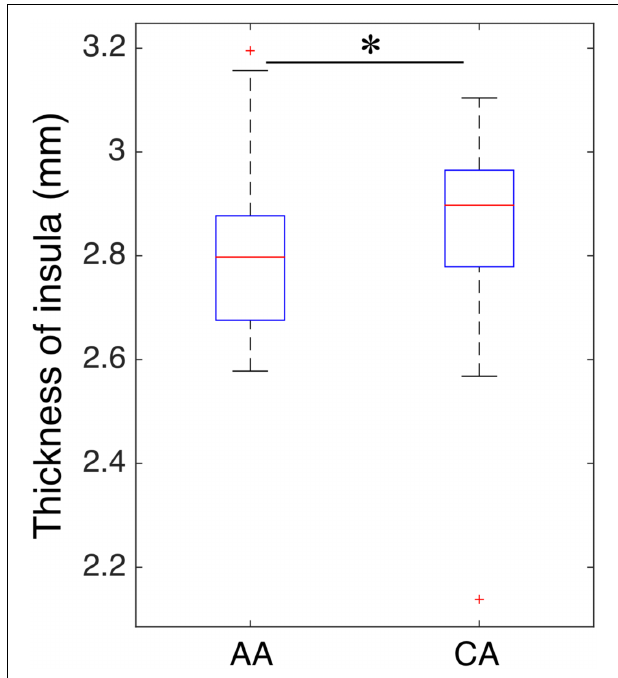
FIGURE 4 | Comparison of insular thickness between African–Americans (AA) and Caucasian–Americans (CA). The thickness had a significantly lower value in AA group than that of CA group ( ∗ indicates statistical significance).